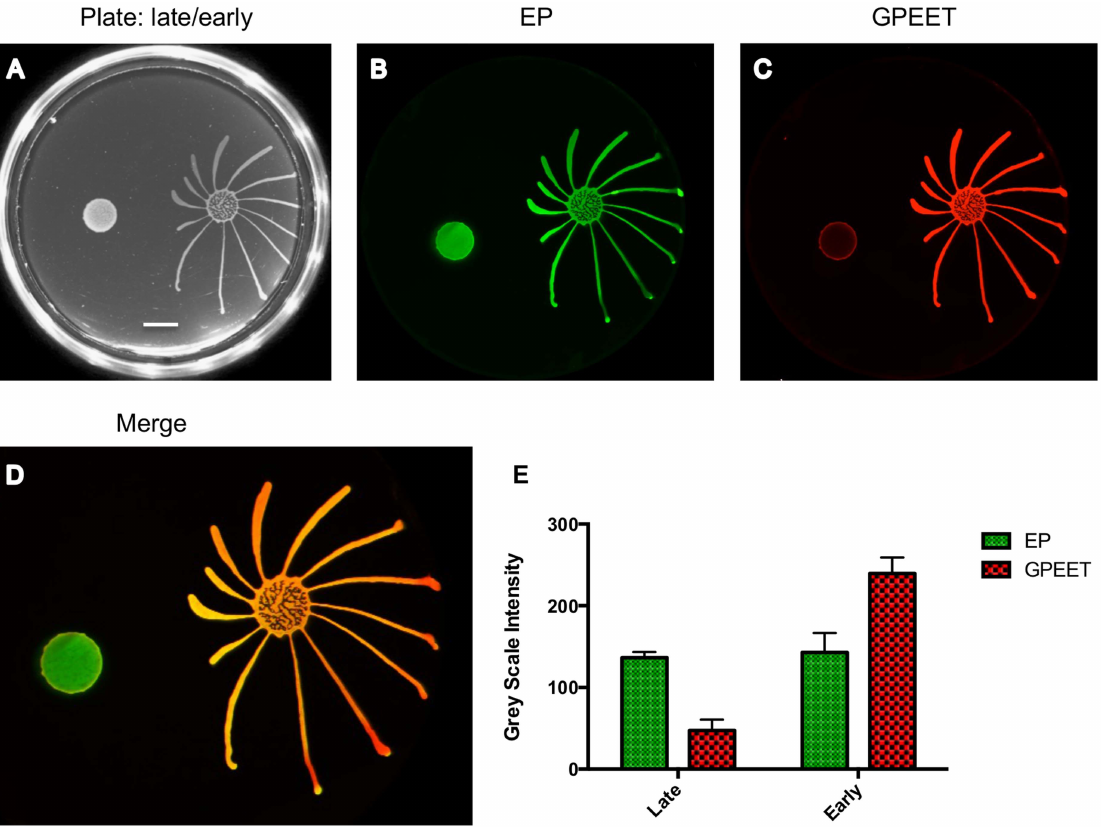
Figure 2. Only GPEET-positive cells exhibit SoMo. 2 6 10 5 procyclic forms growing in medium with or without 20 mM glycerol were inoculated on an agarose plate containing 20 mM glycerol. (A) Photograph of the community 5 days post plating. Scale bar is 1 cm. (B–D) A community lift incubated with a -EP and a -GPEET antibodies. (E) Quantification of signal intensities. The intensity of EP is comparable between the early and the late procyclic communities. GPEET is predominantly expressed in the early, migrating colony. The error bar shows the mean standard deviation of seven individual areas.